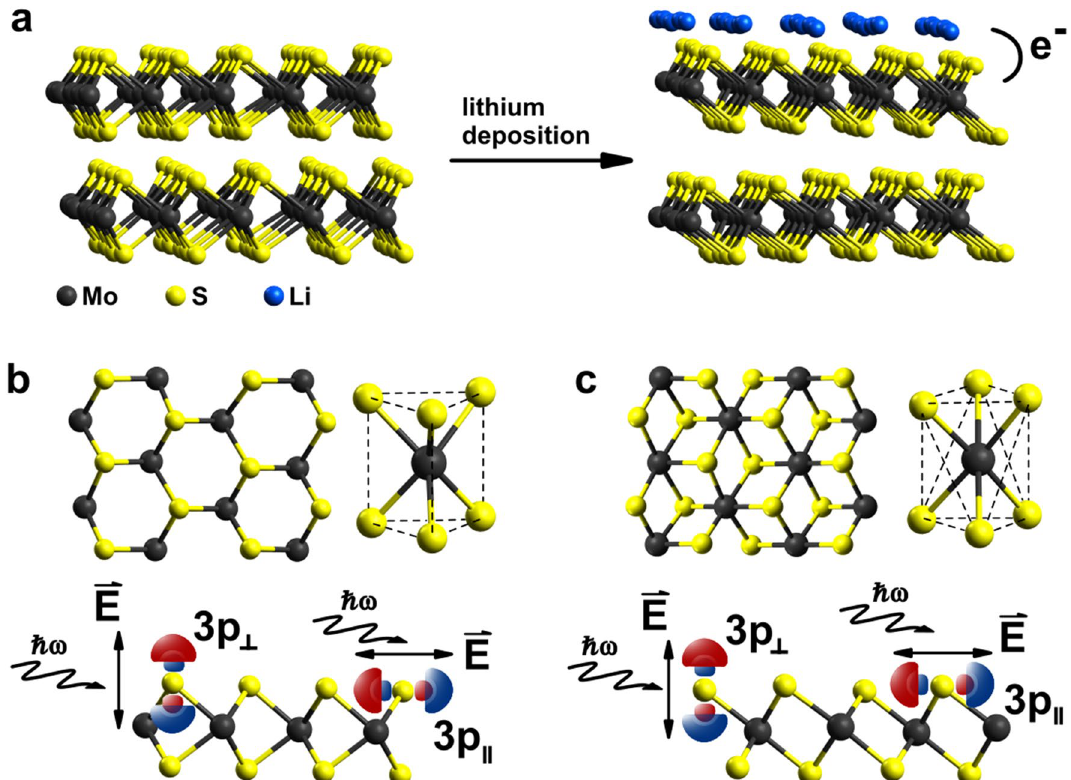
Figure 1. Structure of the semiconducting 2H and the metallic 1T phase of MoS 2 and the directional excitation of an electron into unoccupied S3p states following absorption of linearly polarized X-rays at the S L 1 -edge in the CHC experiment. ( a ) Lithium deposition onto 2H-MoS 2 leads to concomitant intercalation/ adsorption of Li + cations and electron injection, causing the phase transition and formation of 1T-Li x MoS 2 . ( b , c ) Crystallographic structures in top- and side-views of a monolayer of the 2H and the 1T phase. CHC spectroscopy prepares selectively in-plane ( (cid:31) ) and out-of-plane ( ⊥ ) S3p excited states. Black, yellow and blue spheres represent Mo, S and Li atoms, respectively. The crystallographic structure was build using Avogadro software version 1.2.0 32 and edited with Inkscape software version 0.92.3